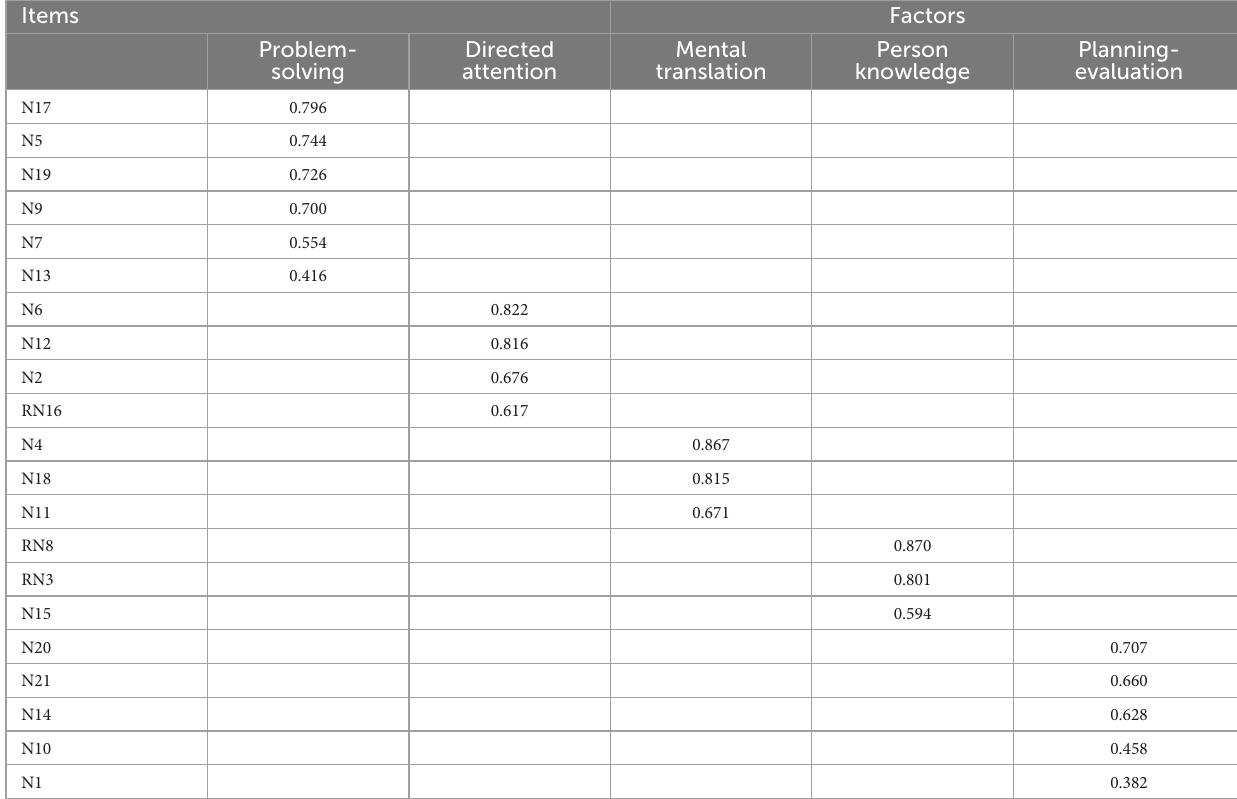
TABLE 1 Factor loadings based on a principal component analysis with varimax rotation for 21 items from the MALQ.